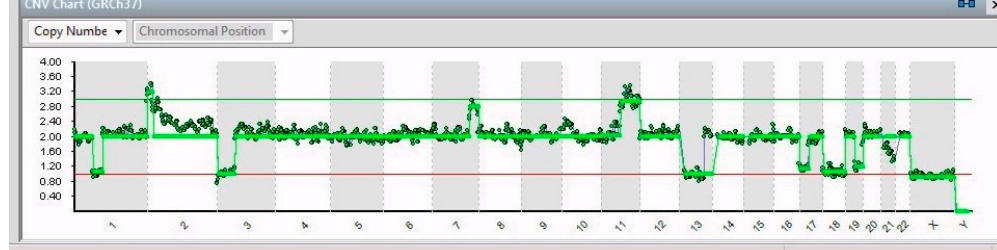
Figure 3. CNV chart related to a single cell from SK-N-BE (2)-C showing, from left to right, partial gain of chromosome 1, partial loss of chromosomes 3, partial gain of chromosomes 7 and 11, a partial loss of chromosomes 13, 17, 19, and 21, and the total loss of the X chromosome.